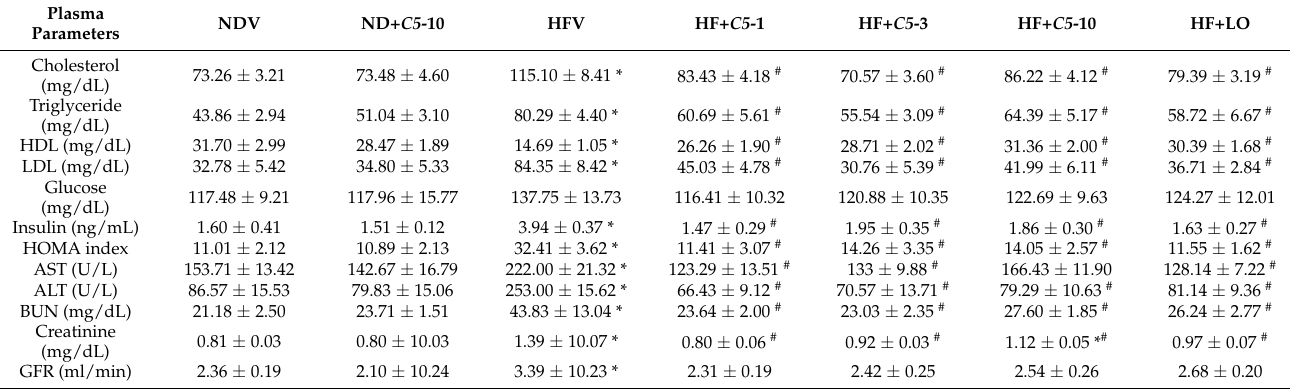
Table 2. Effect of α , β -dehydromonacolin S ( C5 ) on blood biochemical parameters in normal and high-fat diet-induced obese rats.